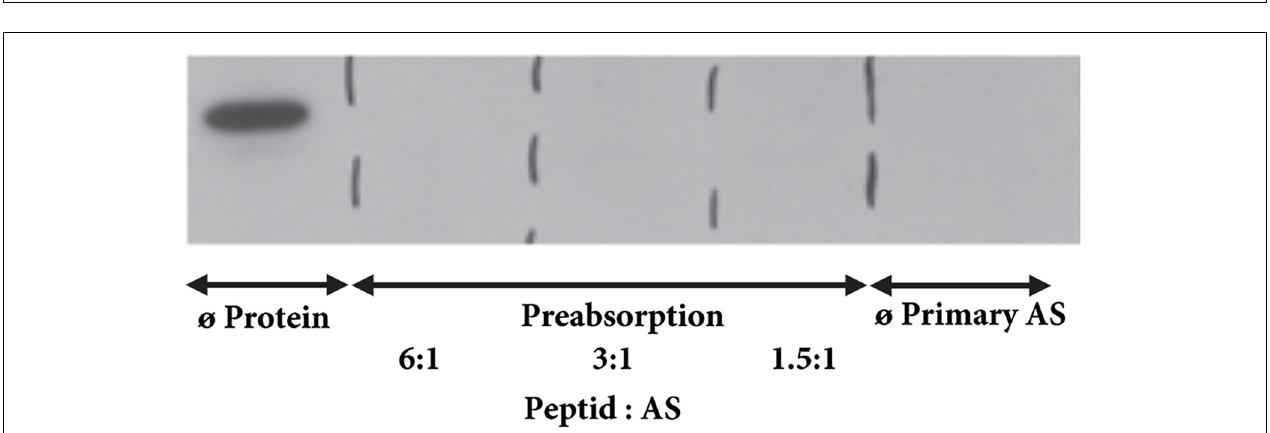
FIGURE 3 | Western blot for NK1R – preabsorption. The NK1R immunoreactive band is detectable when primary antibody was not preabsorbed with corresponding peptide. No immunoreactive band is seen when primary antibody was pre-incubated with corresponding peptide with a 6-fold, 3-fold, or 1.5-fold molar excess of the NK1R peptide or when primary antibody is